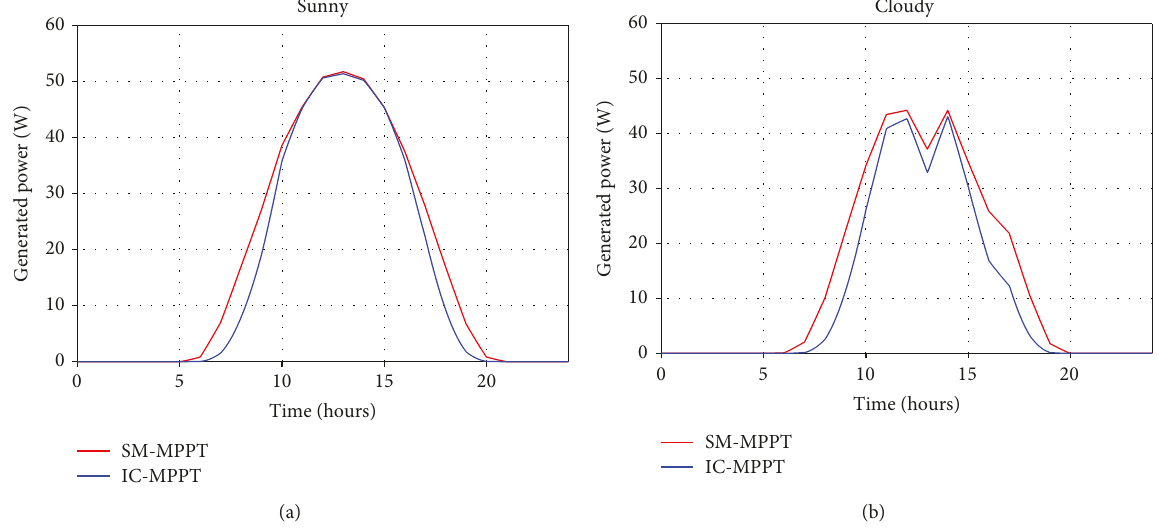
Figure 15: Daily generated power using the SM-MPPT and the IC method for sunny and cloudy whether pro fi